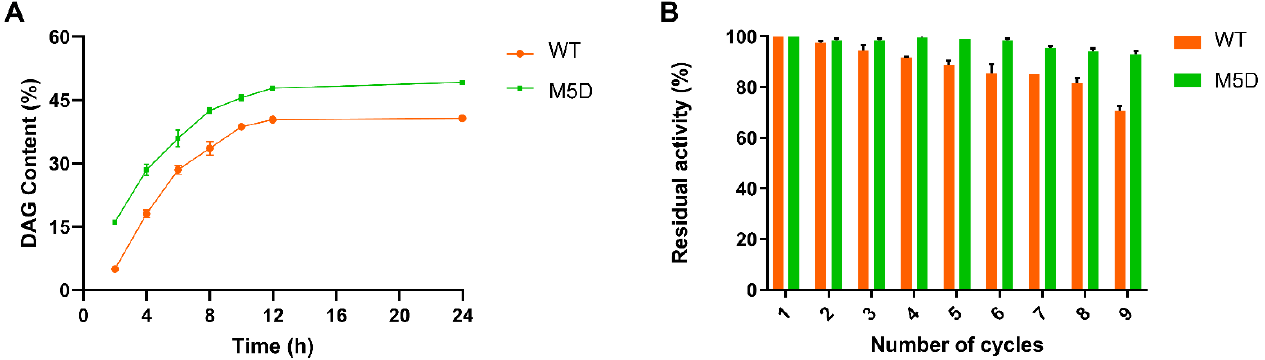
Figure 6. Comparison of the DAG synthesis via esterification catalyzed by the immobilized WT and M5D. ( A ) Time course of total DAG content by the immobilized WT and M5D mutants. ( B ) Operational stability of the immobilized WT and M5D mutants. Error bars represent standard deviations between replicates.